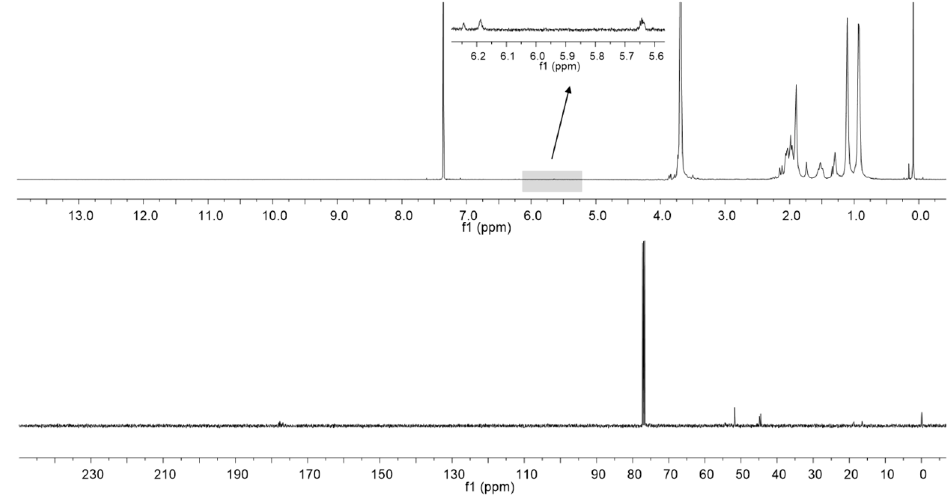
Figure 1. 1 H and 13 C NMR spectra of waste poly(methyl methacrylate) (PMMA) with magnified monomer signals region.